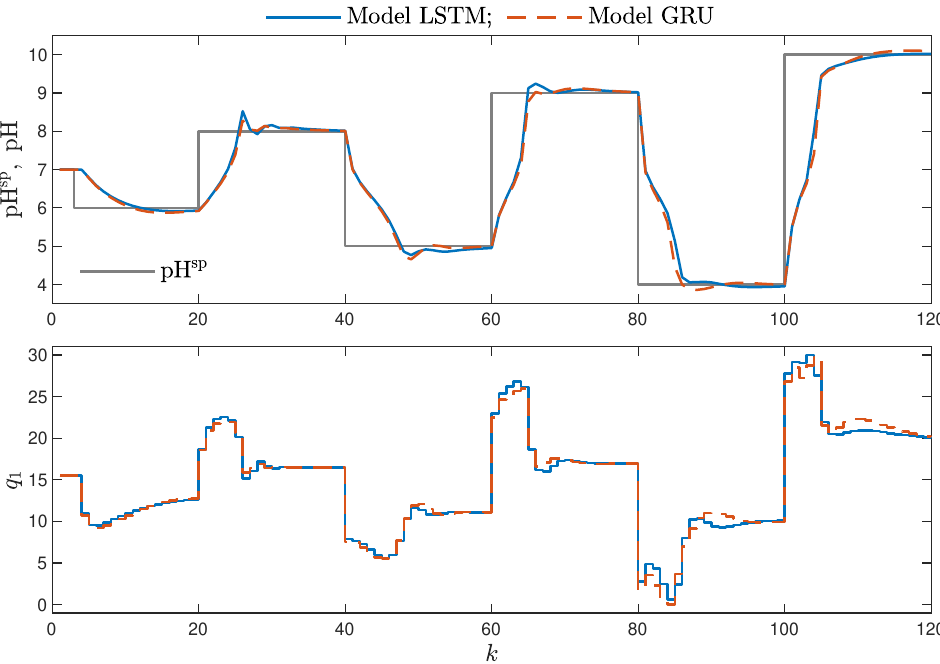
Figure 16. The neutralisation reactor: MPC results with the LSTM and GRU models for n N = 5, n A = n B =